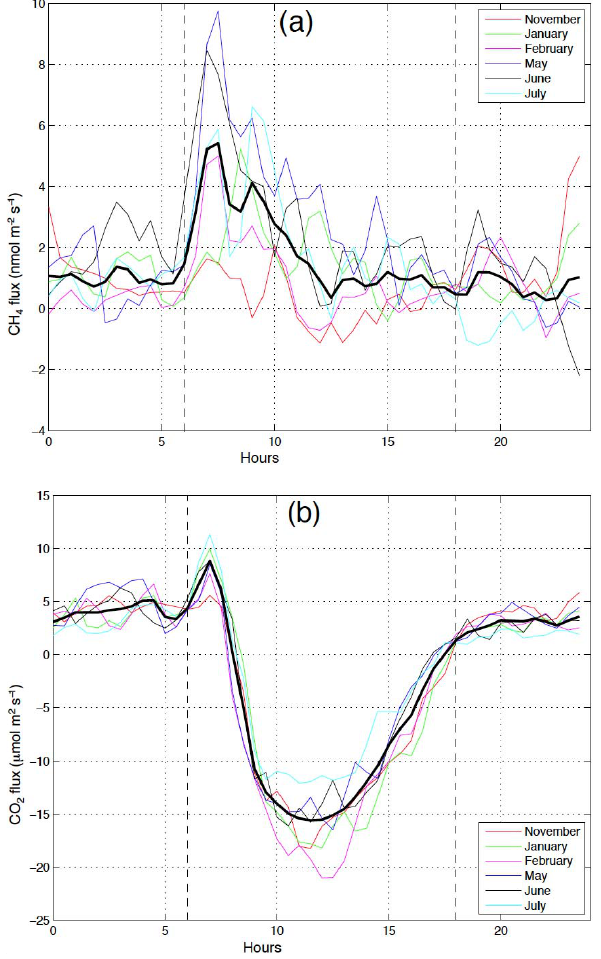
Fig. 6. Monthly averaged diurnal cycles of CH 4 (a) and CO 2 (b) fluxes measured at the top of the K34 tower.